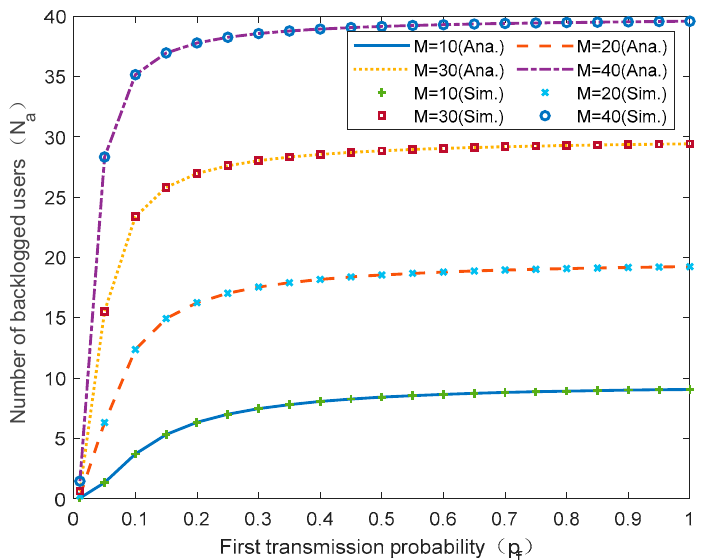
Figure 10. Number of backlogged users vs. first transmission probability (Ana. vs. Sim.).